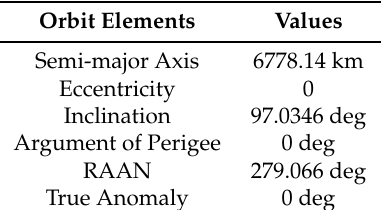
Table 2. Orbit parameters of Sat1.